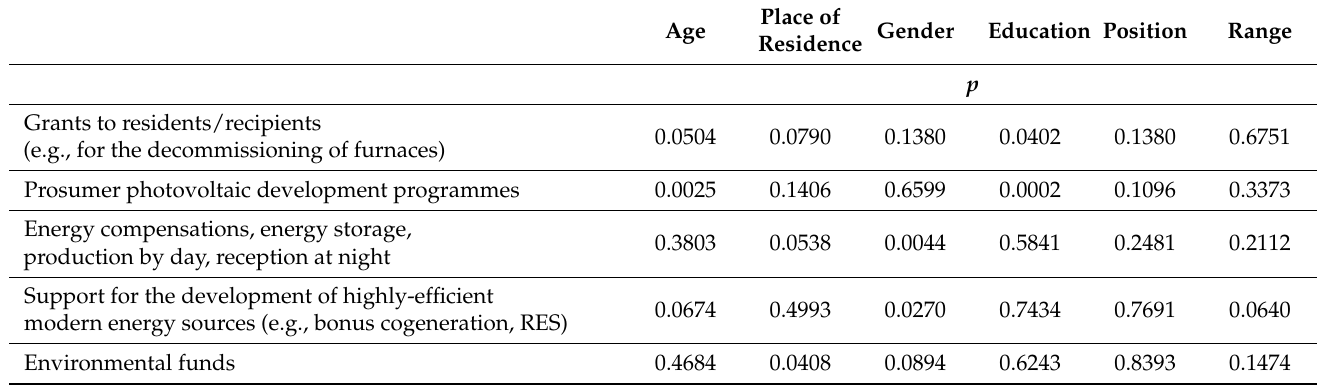
Table 5. Assessment of individual factors and socio-economic characteristics. Source: Own research based on studies conducted using the Kruskal–Wallis H Test and Mann–Whitney U Test. n = 444.